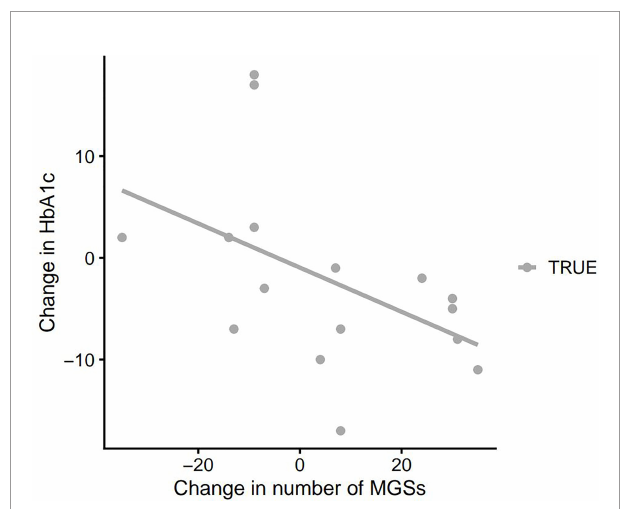
FIGURE 3B | Change in PDFF as a function of KO Bray-Curtis dissimilarity between faecal samples at baseline and 3 months after DMR. PDFF, proton density fat fraction; KO, Kyoto Encyclopedia of Genes and Genomes (KEGG) orthology; DMR, duodenal mucosal resurfacing.